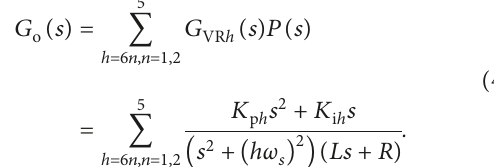
Figure 4: Bode diagram of harmonic current close loop control.